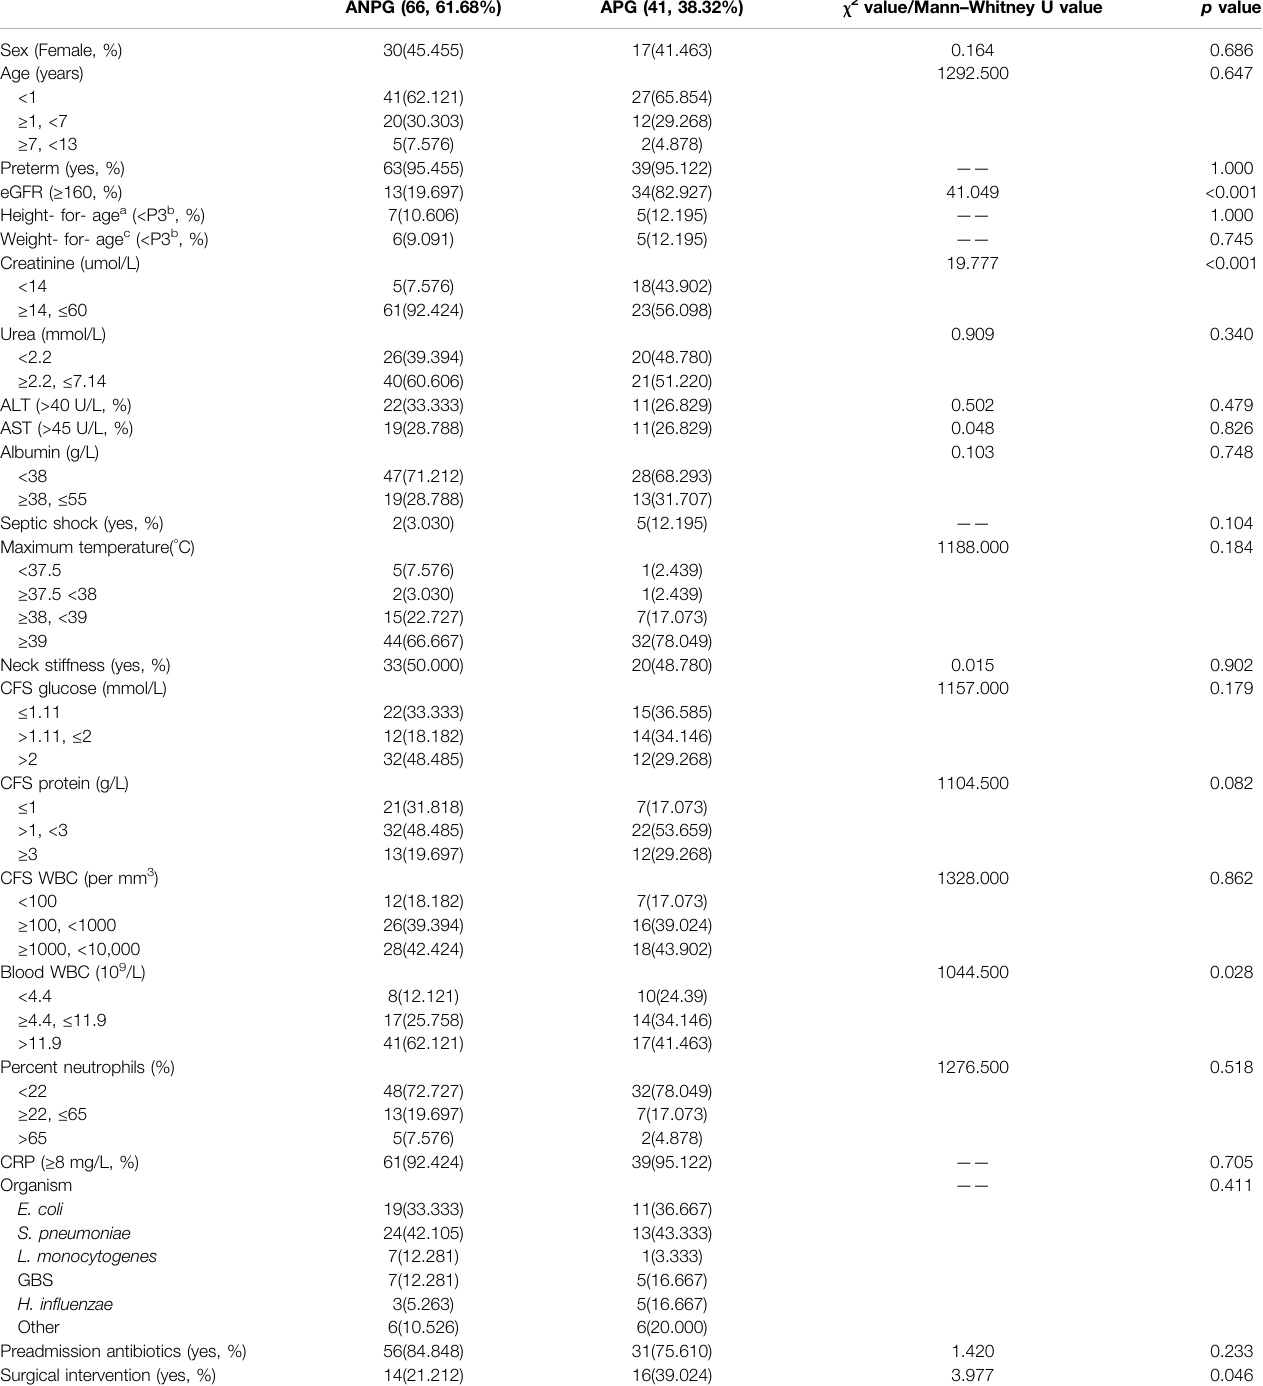
TABLE 1 | Analysis of the demographic and clinical characteristics and laboratory parameters of the two